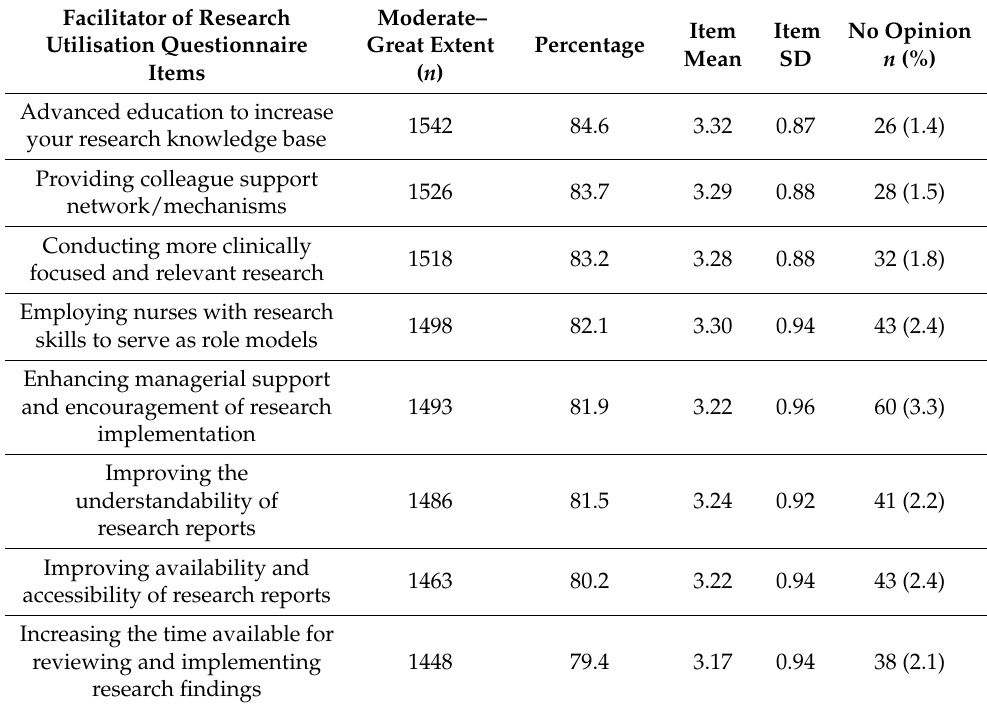
Table 2. Ranking of facilitators of research utilisation (moderate to great extent).